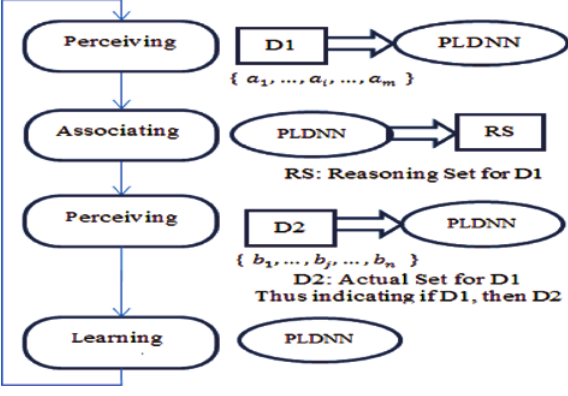
Figure 6: Overview of the Process of Activities of